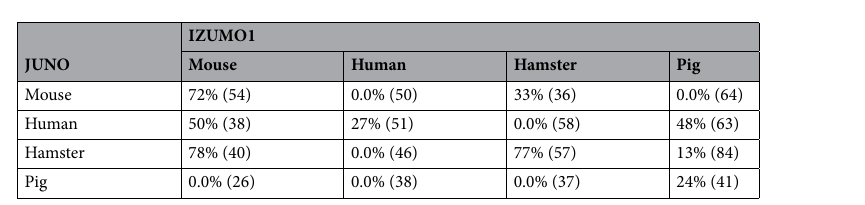
Figure 4. ( A – D ) Translocation and accumulation of conspecific and heterospecific combinations. Dashed lines surround molecular translocation sites (see Video 5). Arrowhead in ( C ) indicates IZUMO1 accumulation; no translocation was observed in this conspecific combination (pig). Bars: 10 µm.